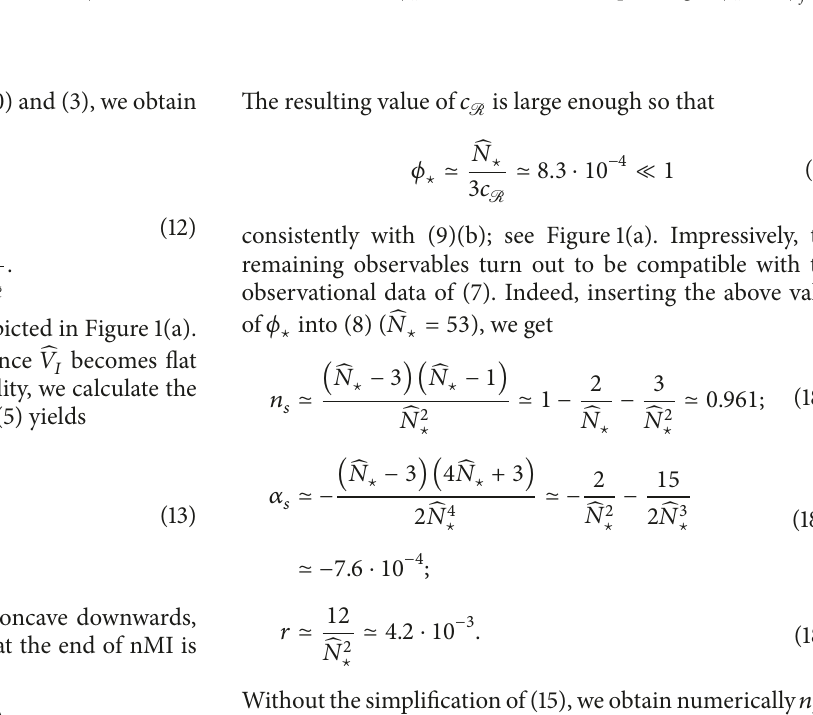
= 1 (b). Values corresponding to 𝜙 ⋆